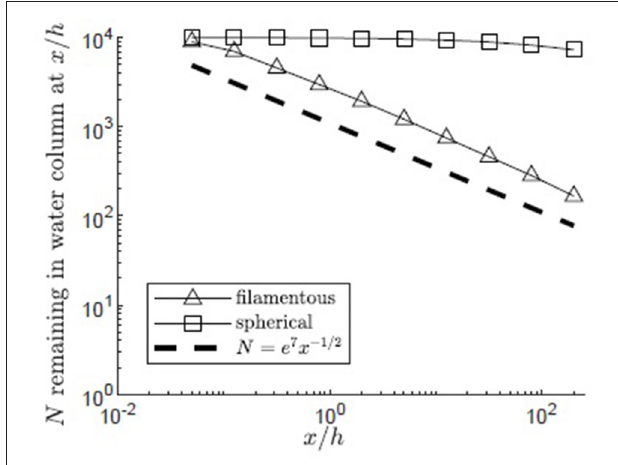
FIGURE 9 | Number of filamentous (open triangles) and spherical (open squares) particles remaining in the water column with distance from the release point x rel / h 0 for 10,000 particles released at z rel / h 1 over a = = canopy ( H / h 5, u 0.01 m/s, L v 1 cm, a 2 m − 1 , C D 1.95, = = = = ∗ = h 1 m) with a reflecting water surface boundary. Particles were evaluated at = 10 points spaced equally in log space, ( x / h 0.05, 0.13, 0.32, 0.80, 2.0, 5.0, = 13, 32, 80, 200). A line illustrating a power law with decay constant 1/2 is − plotted for reference (black dashed